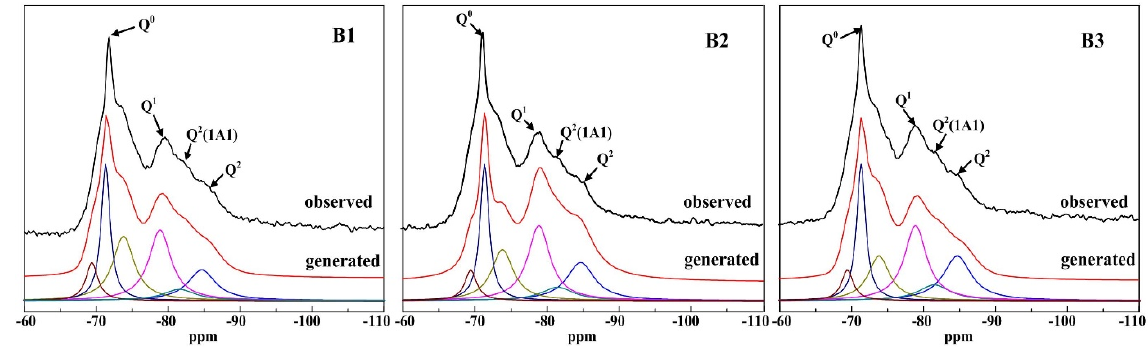
Figure 6. The 29 Si NMR spectra of cement matrix in specimens B1–B3 after 28 days curing time. Table 4. The 29 Si NMR deconvolution results of cement matrix in specimens B1–B3 after 28 days curing